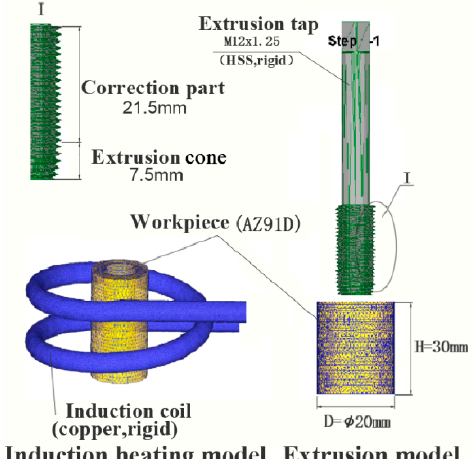
Figure 1. Finite element model.